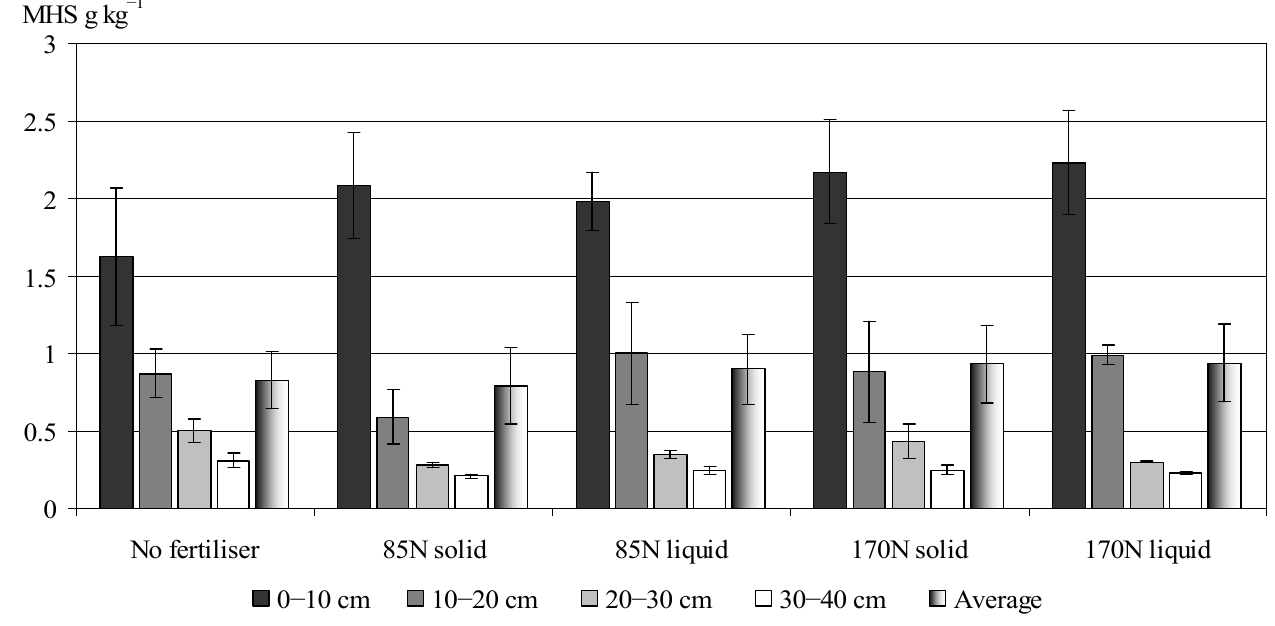
Figure 16. MHS content in grassland in Retisol, 2019.